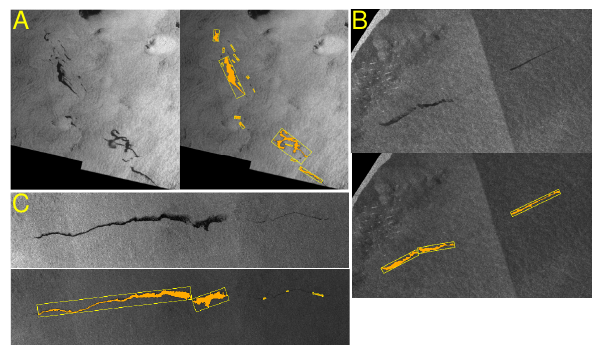
Figure 3. An example of detected potential bilge dump events (shown inside rectangles).